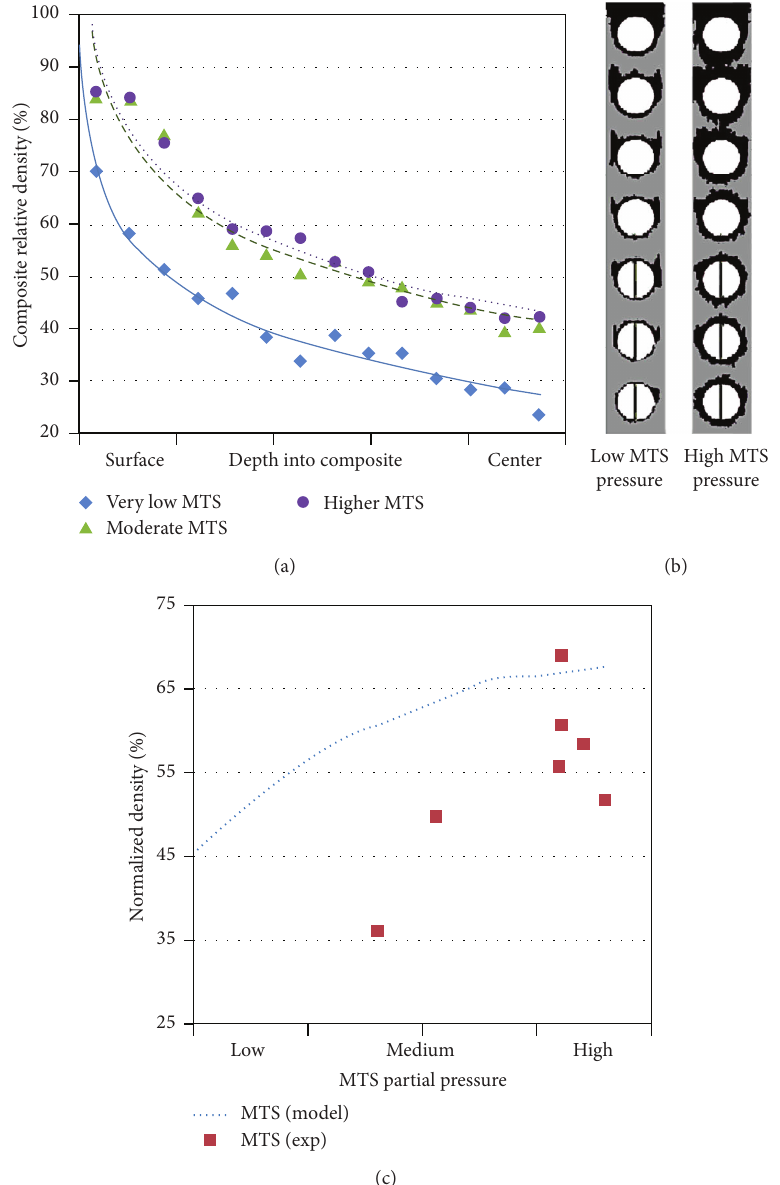
Figure 7: (a) Simulated deposition gradient for varying MTS partial pressures, (b) simulated infiltration for low and high MTS partial pressures, where black indicates deposited SiC matrix, and (c) comparison between simulation and experimental results for MTS concentration effects on